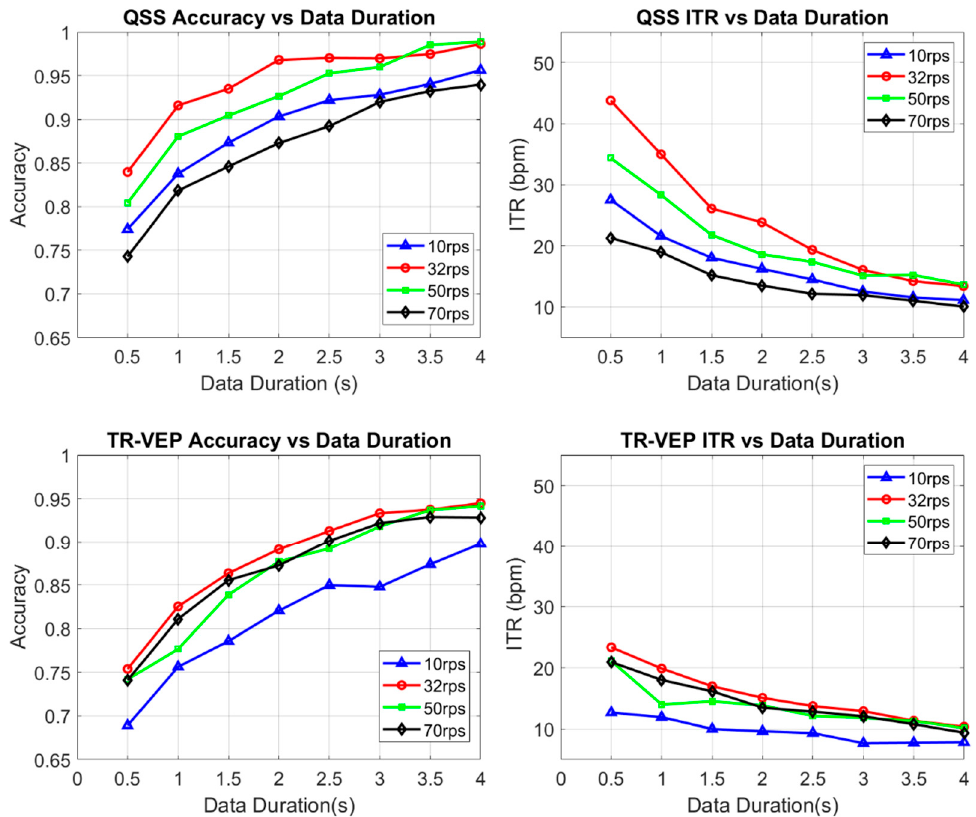
Figure 4. QSS-VEP performances for left and right gazes were averaged as single QSS-VEP performance parameter at each rate. For single sweep 0.5 s, 1 s, and 1.5 s, 32 rps had the highest accuracy and ITR performance (p < 0.05) with QSS-VEP signature while 70 rps had the lowest performance (p < 0.05). For the eight subject population, average ITR values for QSS-VEP (top-right) and TR-VEPs (bottom-right) were plotted for each rate and data durations.